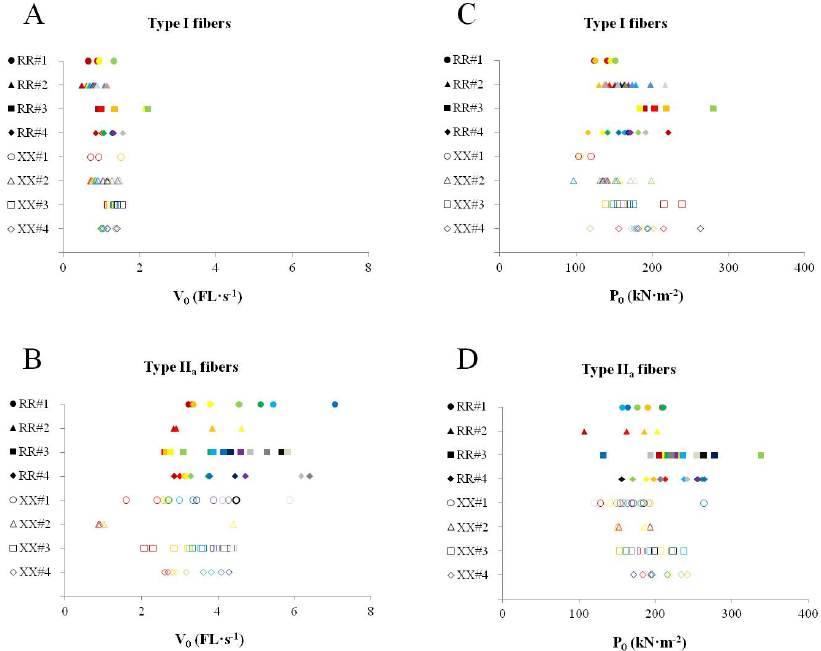
Fig 1. Results for V 0 (FL/s) of type I (A) and type II a fibers (B), as well as for normalized force (kN/m²) of type I (C) and type II a fibers (D) displayed as per participant. RR = filled markers, XX = blank markers. Matched participants have the same marker shape. Each individual fiber has the same marker color in panel A and C and panel B and